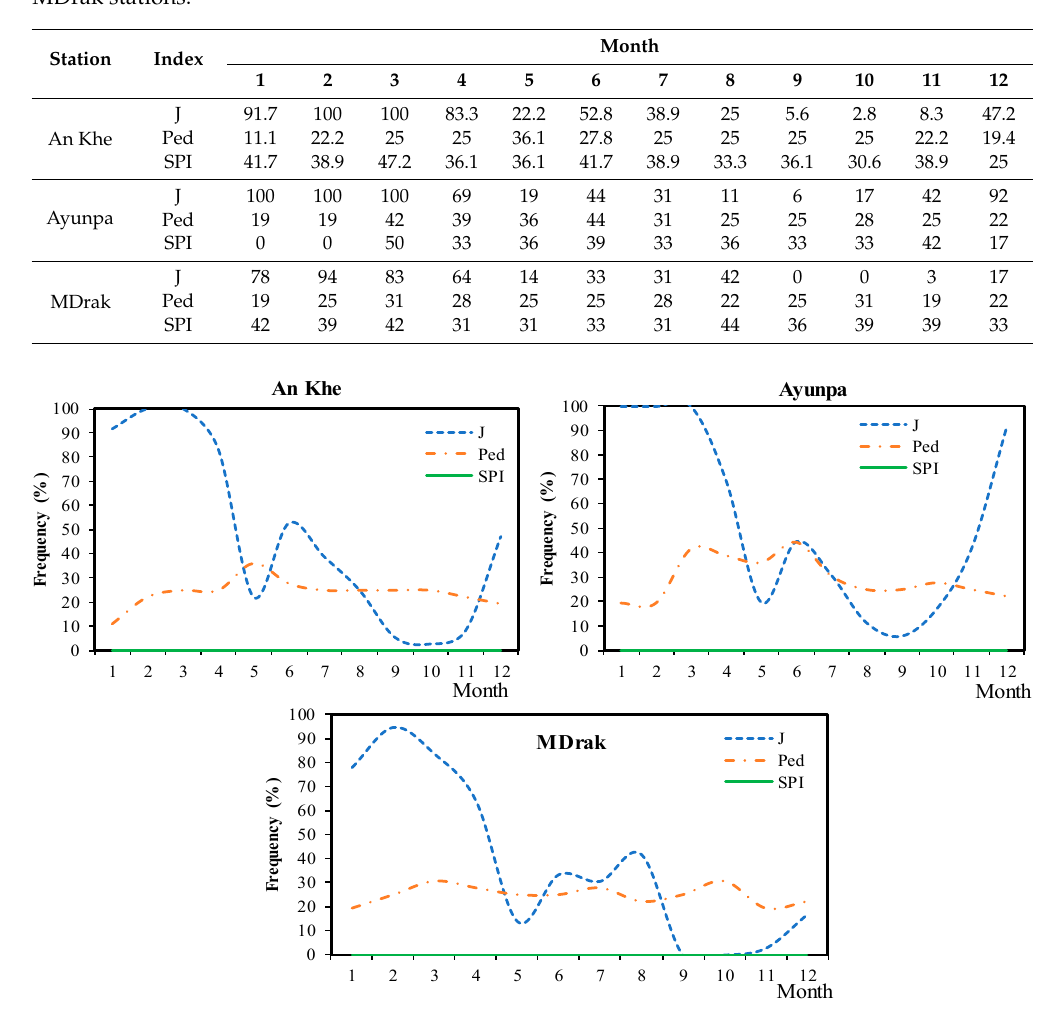
Figure 4. The frequency distribution of monthly drought, based on the three indices, at the stations of An Khe, Ayunpa, and MDrak.